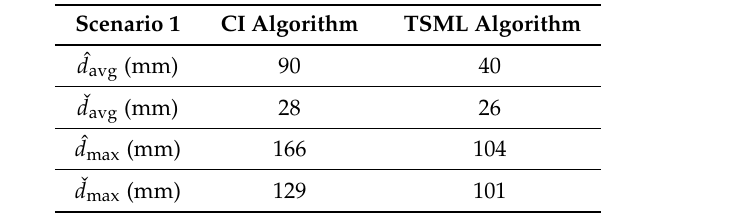
Table 2. The average and the maximum distance between the true TN position and its estimates with ( ˇ d avg , ˇ d max ) and without ( ˆ d avg , ˆ d max ) the use of the statistical model, when using the CI algorithm and the TSML algorithm, are shown.